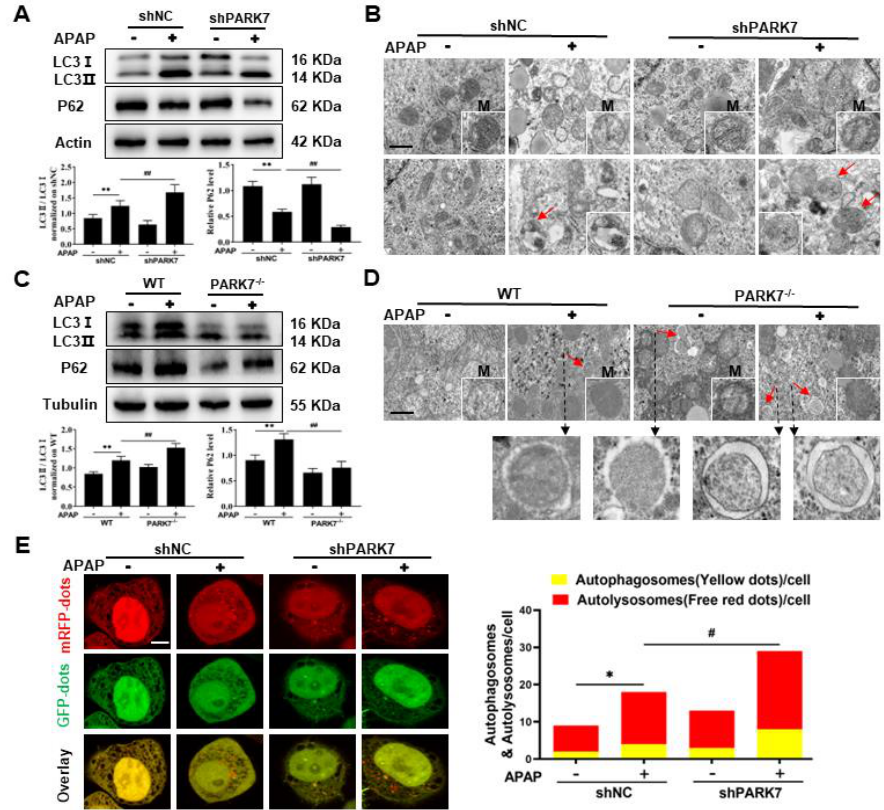
Figure 4. Silencing PARK7 promoted mitochondrial autophagy. ( A ) Changes in LC3 and P62 proteins in APAP-treated L02 cells with and without PARK7 silencing and statistical analysis, N = 3. ** p < 0.01 vs. shNC group, ## p < 0.01 vs. shNC+APAP group. ( B ) Ultrastructural changes in mitochondria and autophagosomes in L02 cells under APAP intervention with or without PARK7 silencing, N = 3. M represents mitochondria, and the red arrow represents autophagosomes. ( C ) WB and statistical analysis of LC3 and P62 proteins in liver tissue of mice with and without APAP intervention with PARK7 knockdown, N = 3. ** p < 0.01 vs. WT group, ## p < 0.01 vs. WT+APAP group. ( D ) Ultrastructural changes in mitochondria and autophagosomes in liver tissue of mice with and without APAP intervention with PARK7 knockdown, N = 3. Black arrows indicate enlarged images of autophagosomes. ( E ) Changes in autophagy flux in APAP-treated L02 cells with or without PARK7 silencing, N = 3. * p < 0.05 vs. shNC group, # p < 0.05 vs. shNC+APAP